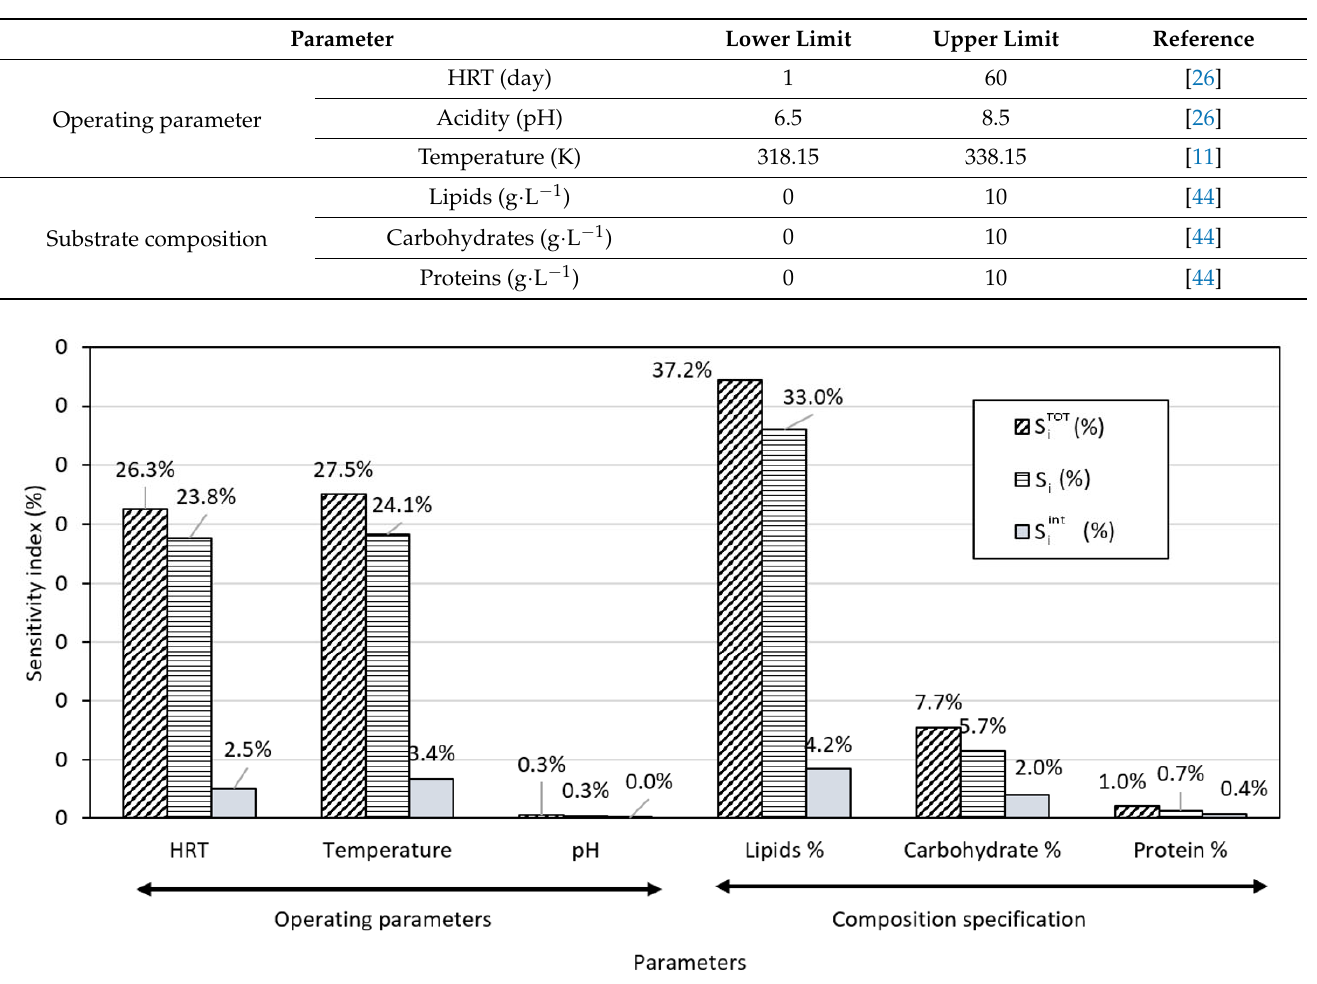
Table 3. Parameters and their ranges considered for the GSA for the bioreactor.